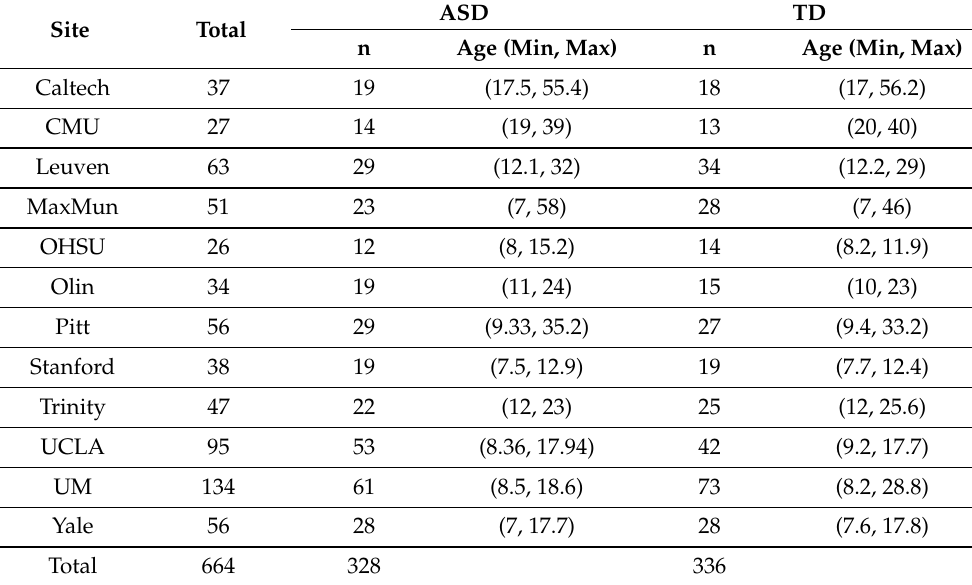
Table 1. ABIDE data phenotypical information summary after sites’